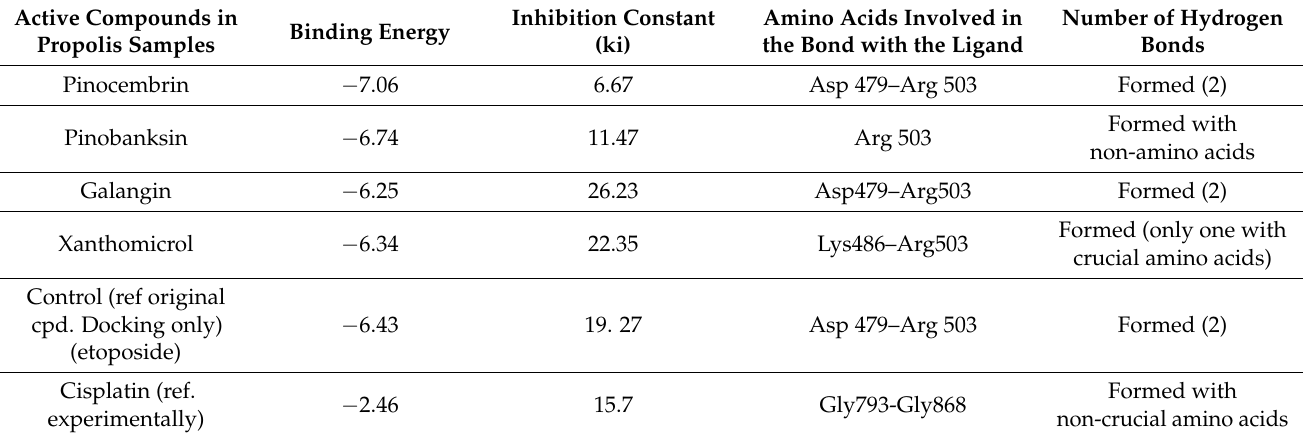
Table 3. Molecular interactions of the propolis active compounds with topoisomerase II β